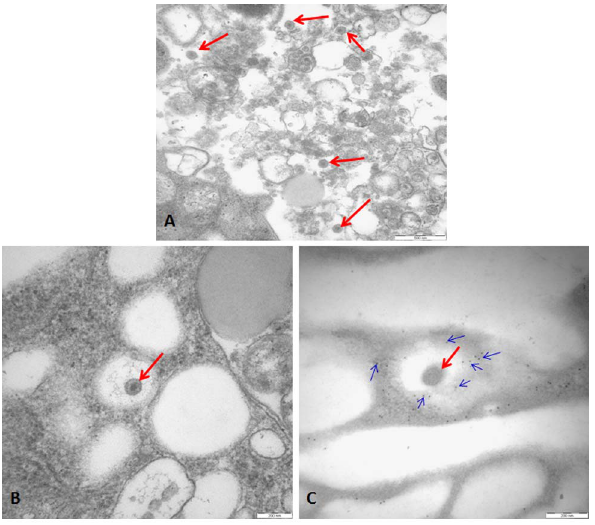
Fig. 4. Microscopic analysis of rHPRS-103EGFP particles. A, Electron microscopy of ultrathin sections of rHPRS-103EGFP-infected DF-1 cells revealed the virion. Scale bar 5 500 nm. B, The zoomed-in images of individual virion in electron microscopy of ultrathin sections. Scale bar 5 200 nm. C, The individual virion in immunogold labeling on ultrathin cryosections. Scale bar 5 200 nm. The red arrows point to virion. The blue arrows point to EGFP.